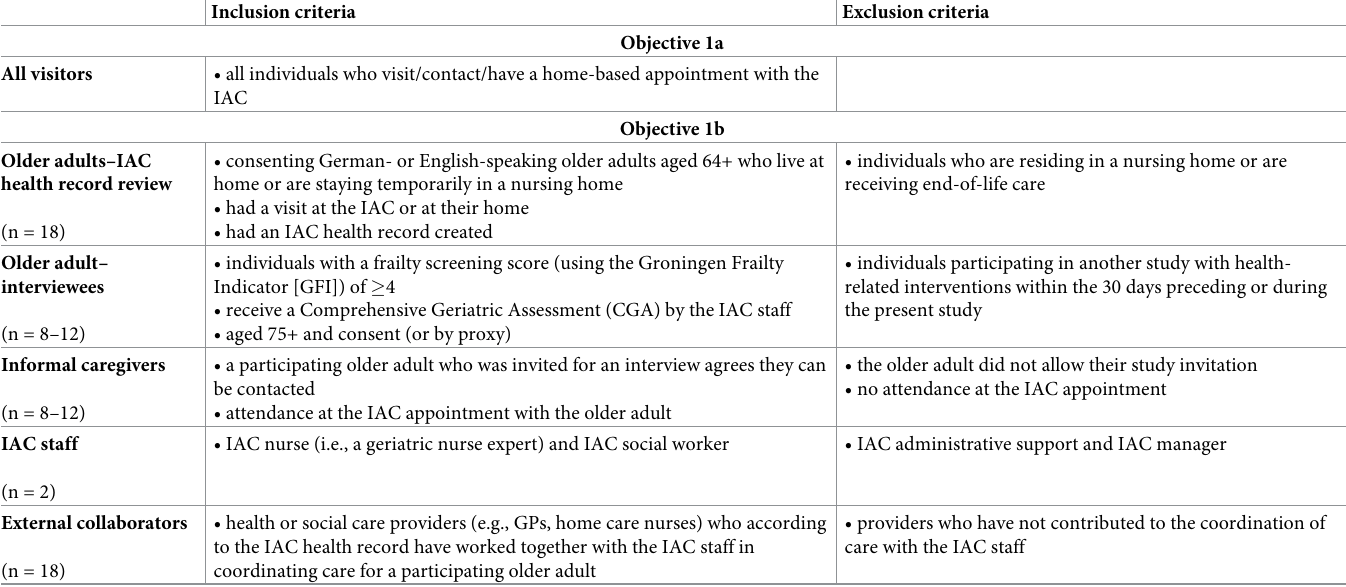
Table 1. Eligibility criteria for study